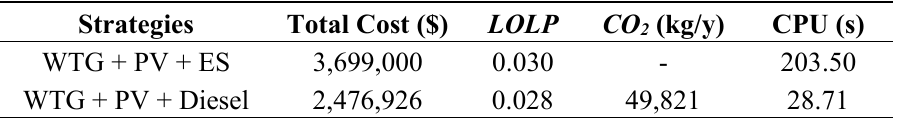
Table 5. Results obtained by two strategies.